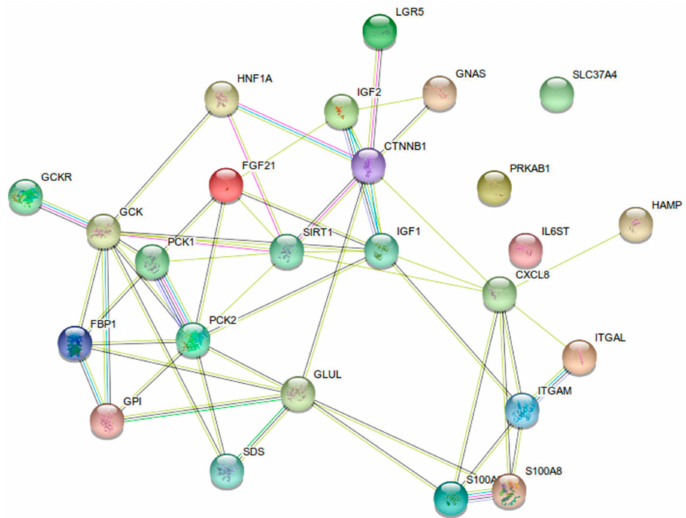
Figure 3. Protein-protein interaction map of possible biomarkers for GSDI extracted from Table 1 using